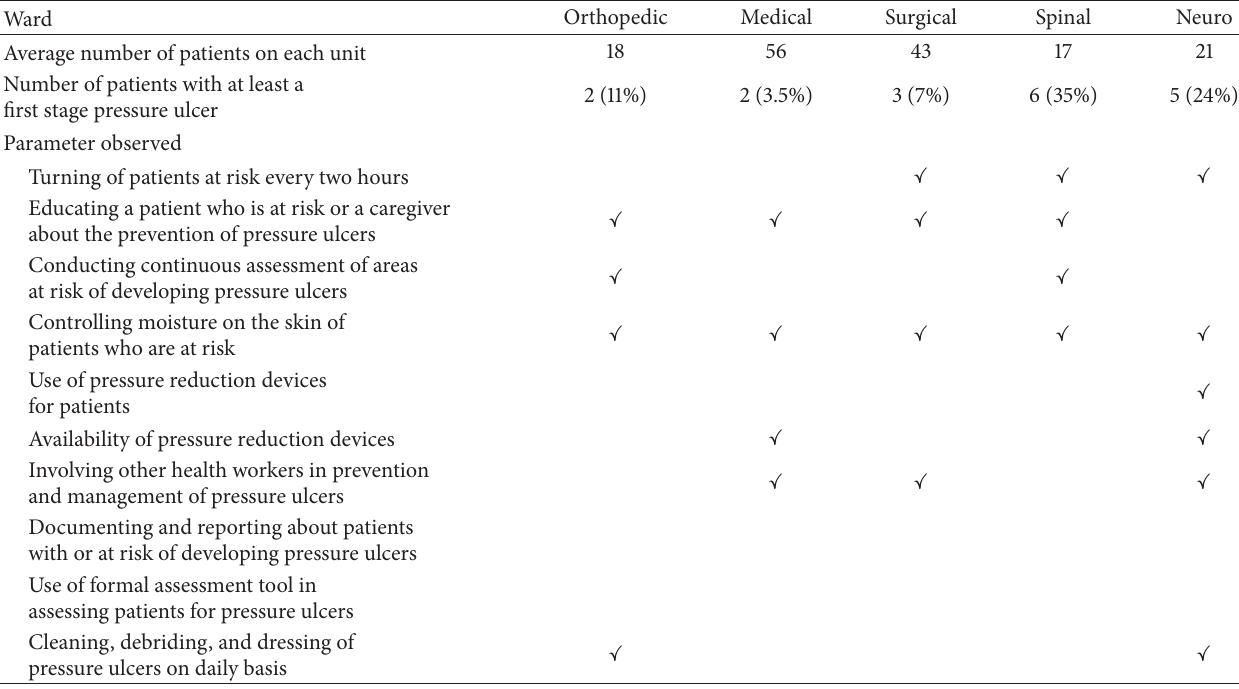
Table 4: Observations made during the daily nursing activities (recorded for one week on each ward studied). Ward Orthopedic